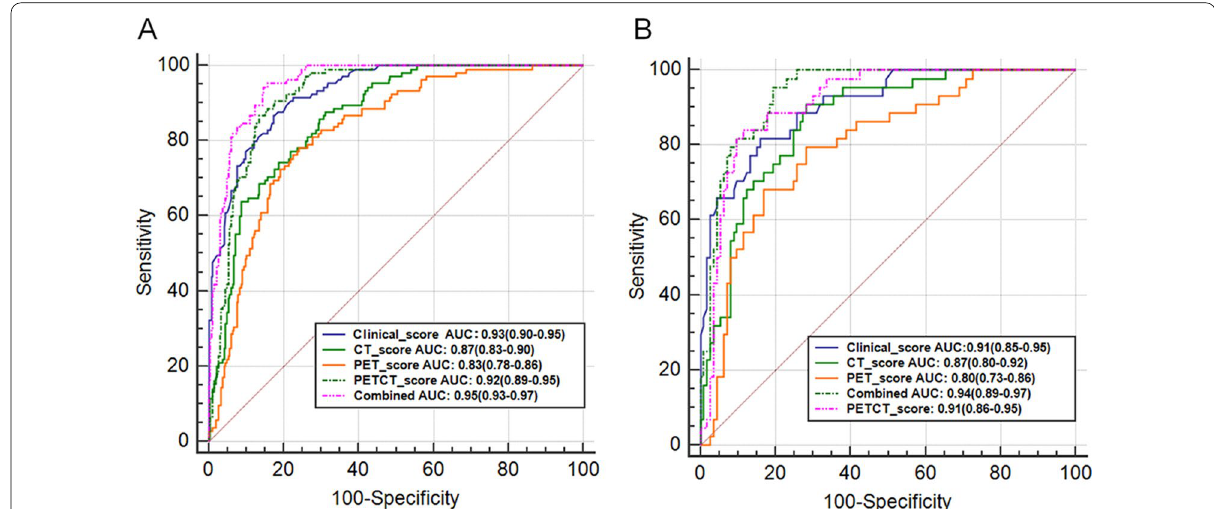
Fig. 2 ROC curve analysis of five predictive models, including the clinical model, CT radiomic model, PET radiomic model, PET/CT radiomic model, and combined PET/CT radiomics-clinical model in the training group ( A ) and test group ( B ), respectively